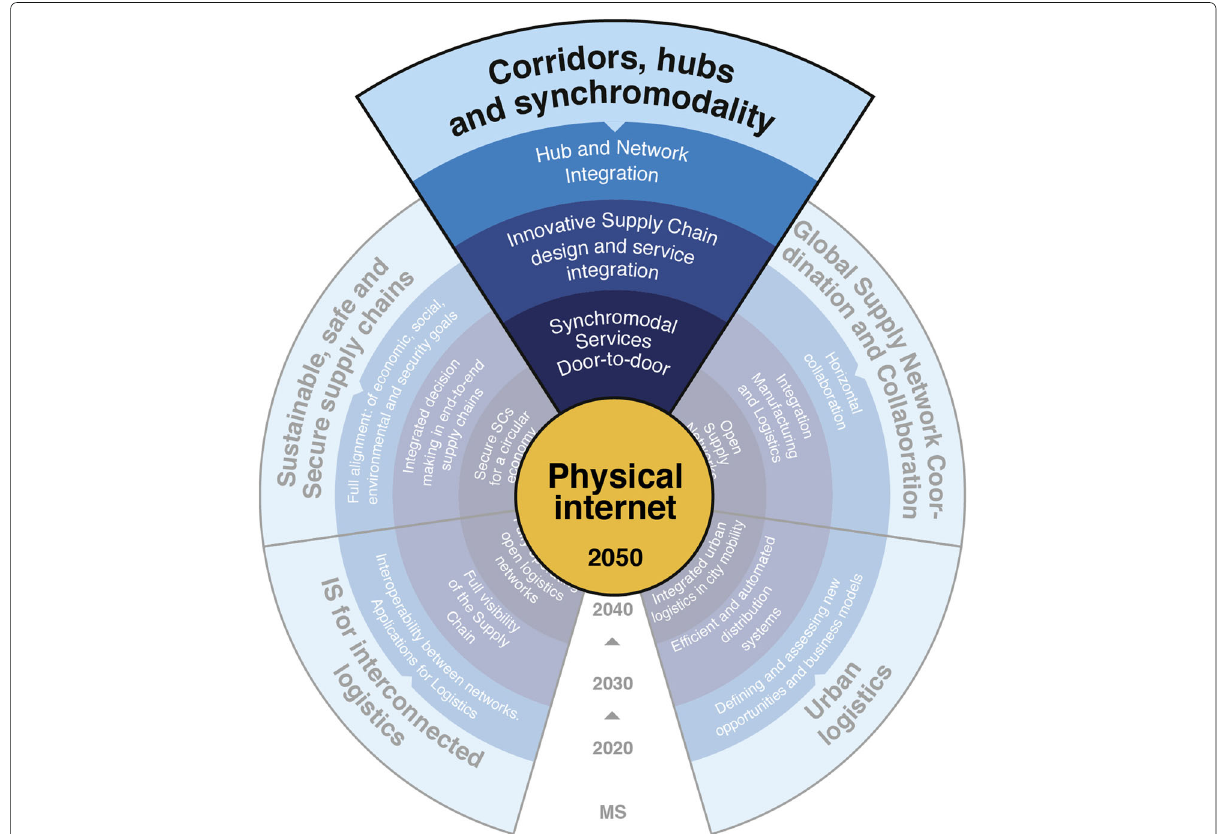
Fig. 1 Synchromodality is one of the road-maps of the Physical Internet [4]